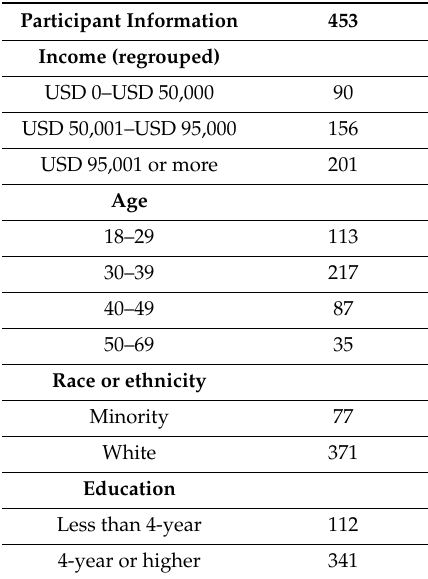
Table 1. Participants